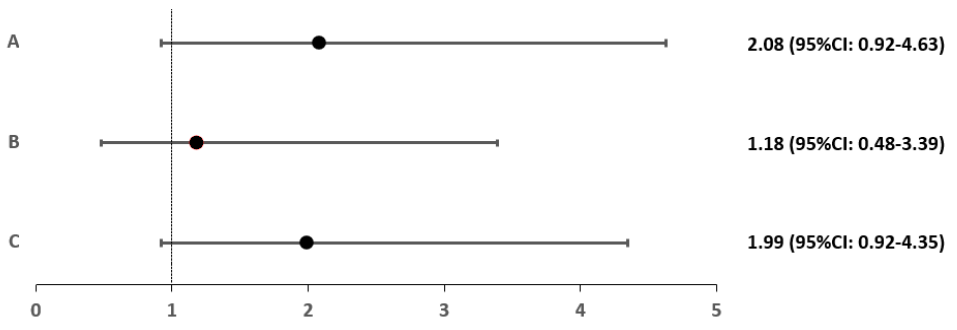
Figure 2. Relative risk of RLS occurrence in groups A, B and C.